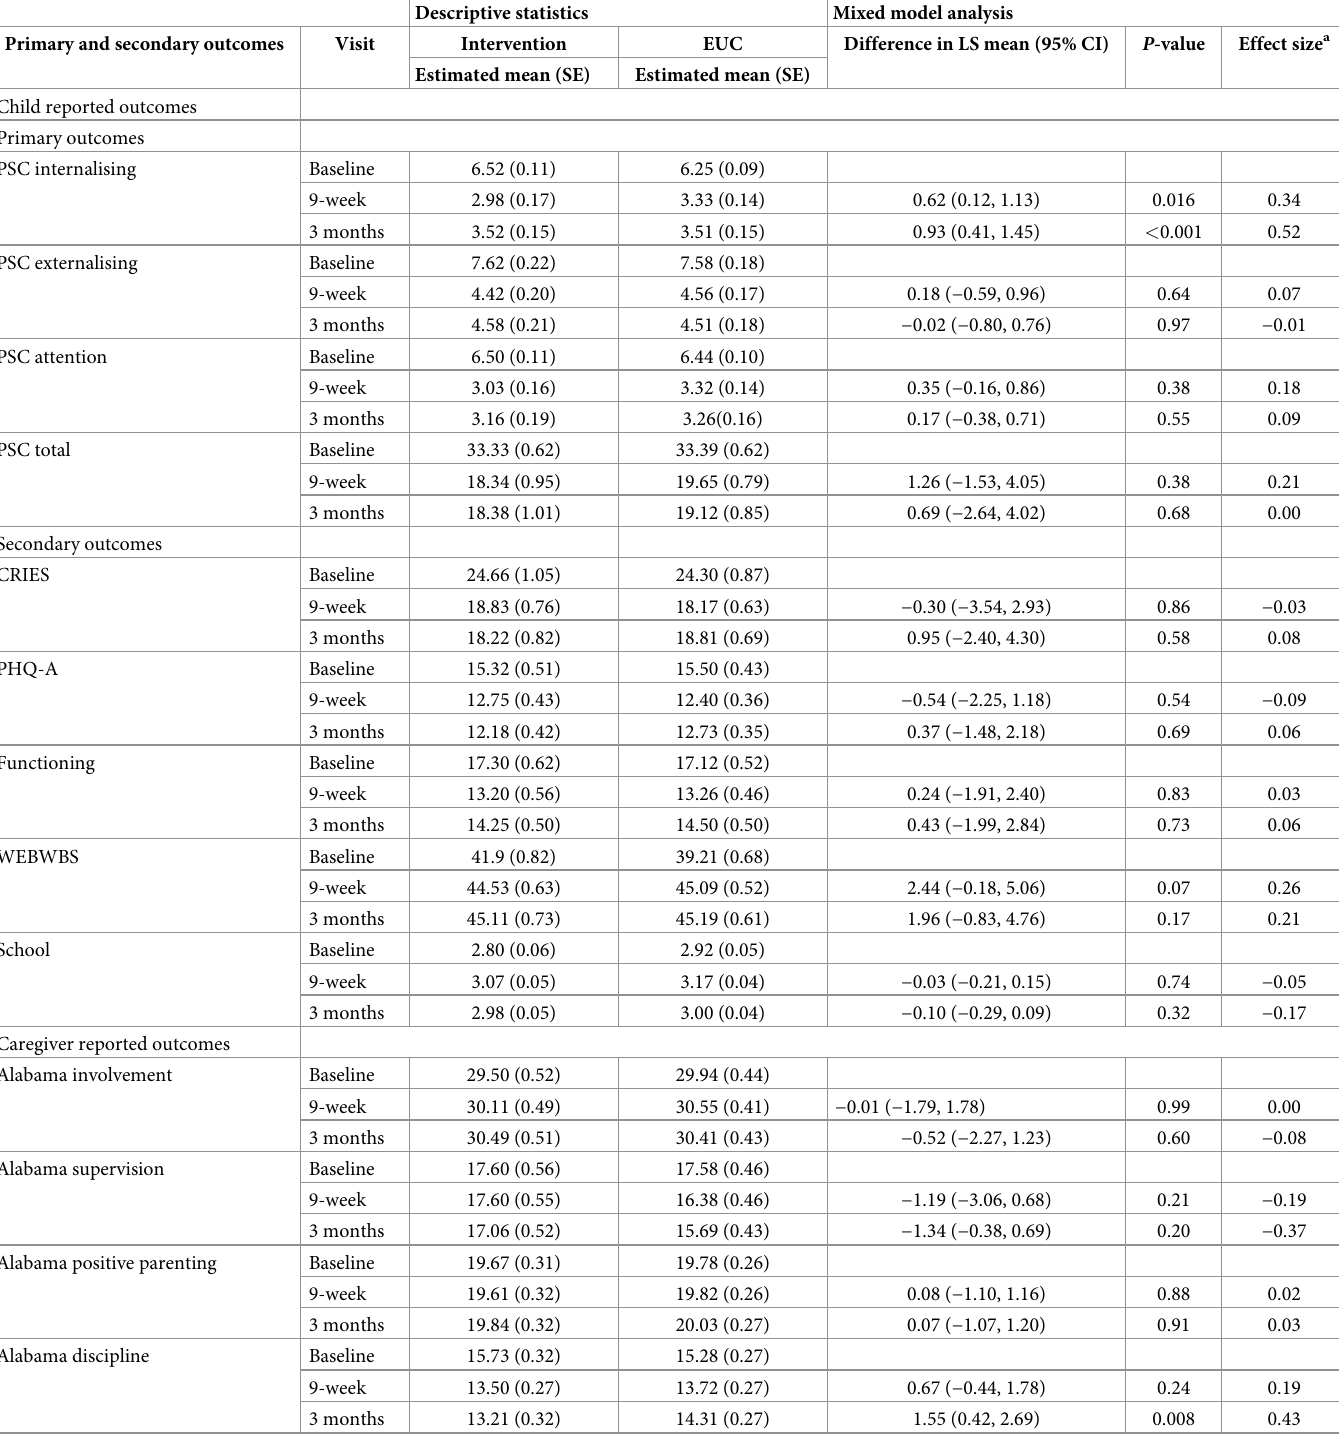
Table 4. Summary statistics and results from mixed model analysis of primary and secondary outcomes for adolescents with internalising